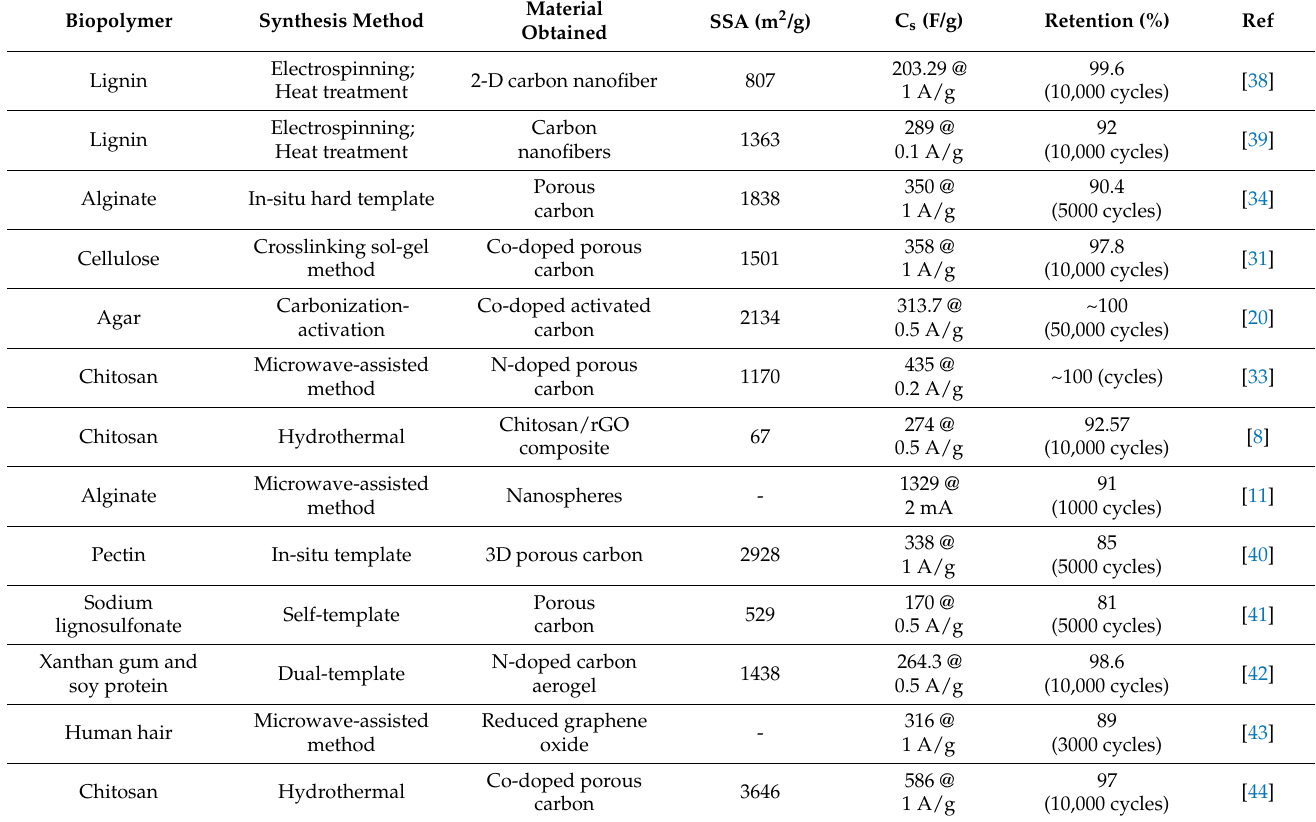
Table 1. Overview of electrode materials synthesized from biopolymer-based materials for super- capacitor applications.